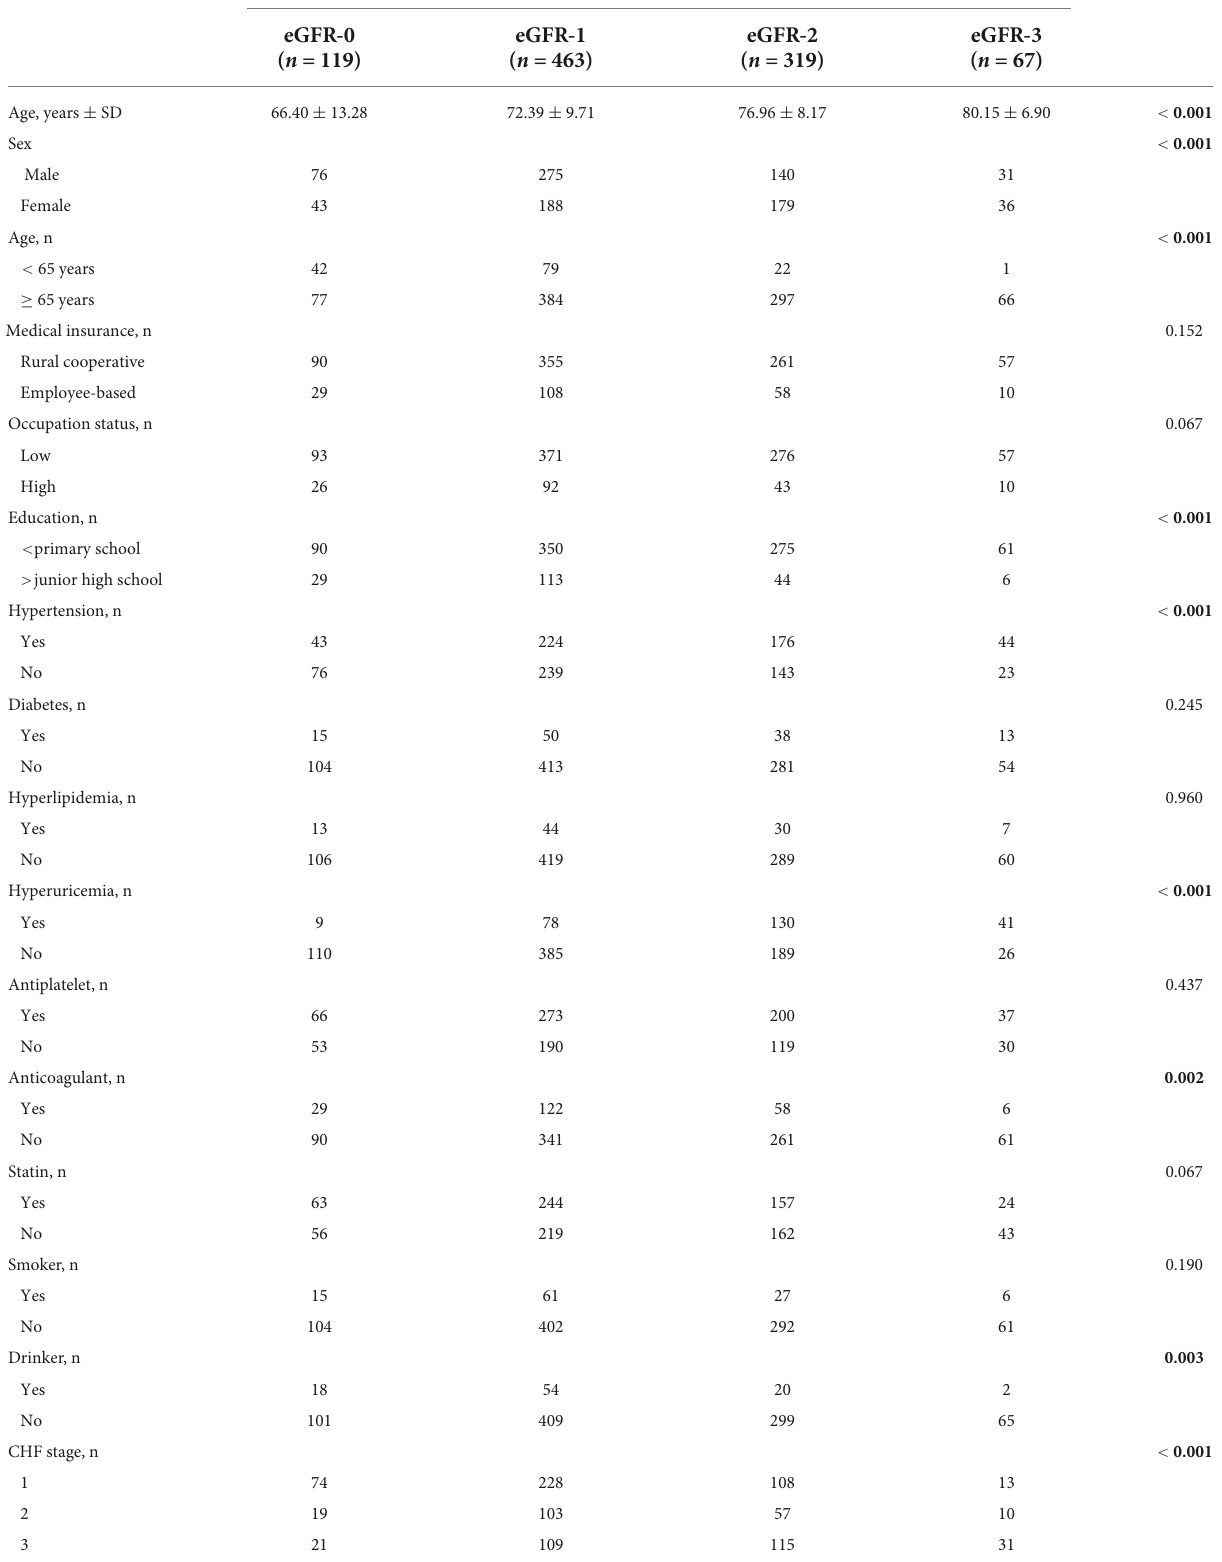
TABLE 1 Baseline characteristics of patients in different estimated glomerular filtration rate (eGFR) groups who were admitted for atrial fibrillation. Variable eGFR